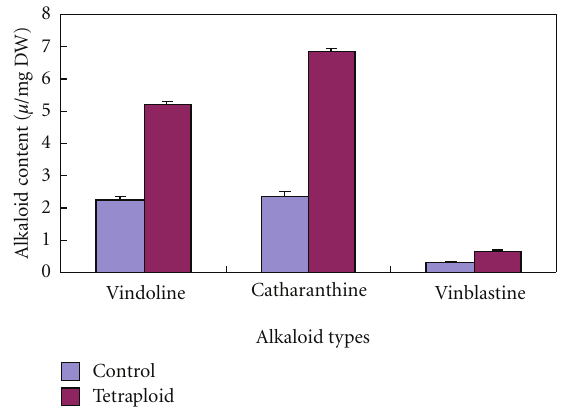
Figure 4: Di ff erence of the average content of TIAs alkaloidsamong tetraploid plants and controls in C. roseus